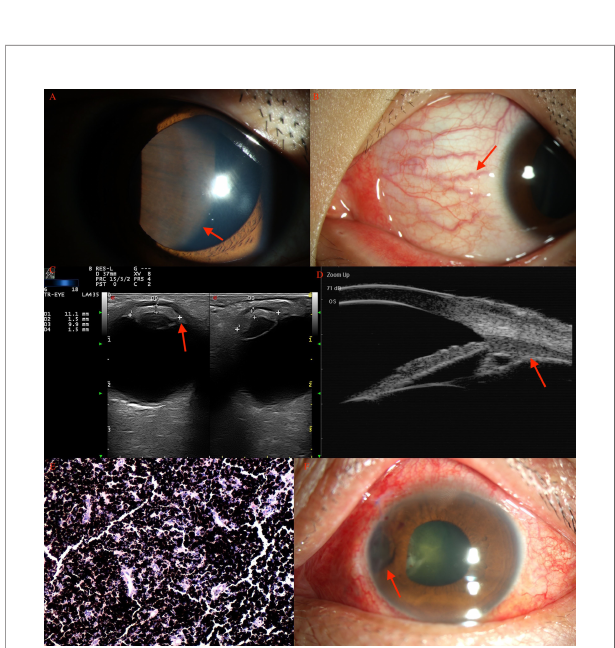
FIGURE 3 | Ciliary body melanocytoma ( A , arrow) of a 15-year-old boy, with prominent sentinel vessels ( B , arrow). (C) CDI revealed lesions (arrow) with moderate internal re fl ectivity with irregular borders. (D) UBM showed a mass (arrow) pushing the normal iris posteriorly. (E) Histopathology revealed an amount of melanin in the tumor cells, with a small, round, normochromic, and regular nucleus. (F) After PTSU combined with MVRE.